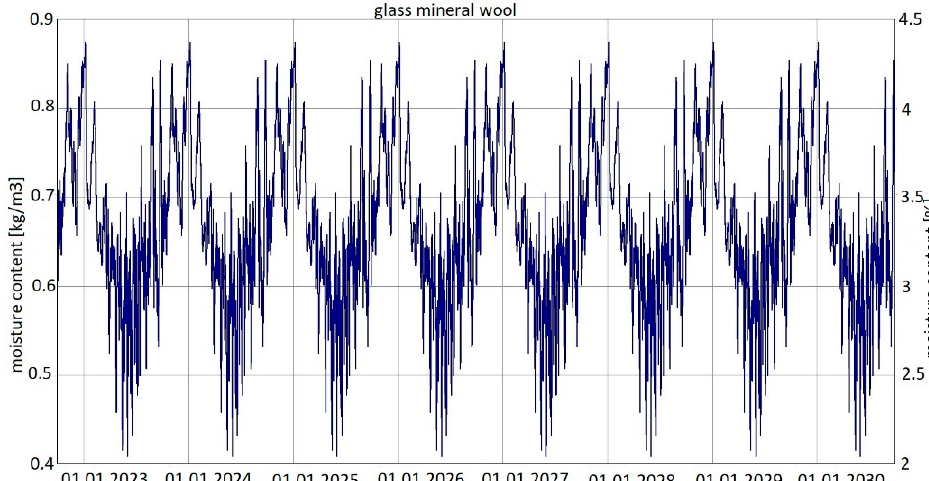
Figure 12. Changes in moisture content in glass mineral wool over eight years, variant 4 [70]. The moisture level for mineral wool during the analysed period ranged from 2.1% to 4.7%; and for plasterboard, depending on the season, it ranged from 0.3% to 0.85%.